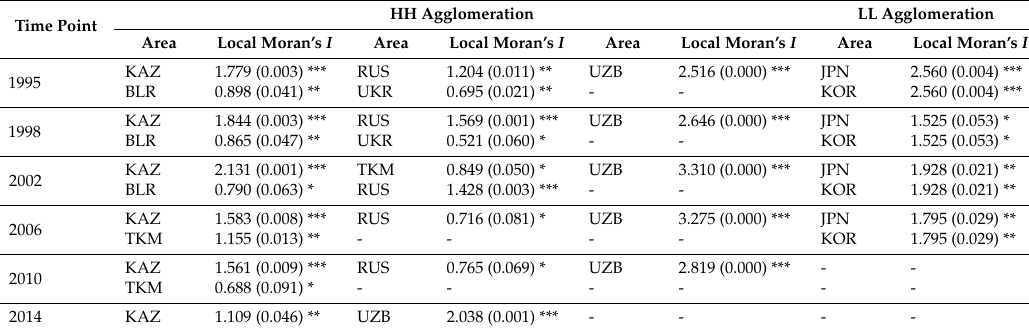
Table 4. Local Moran’ I values in the key time